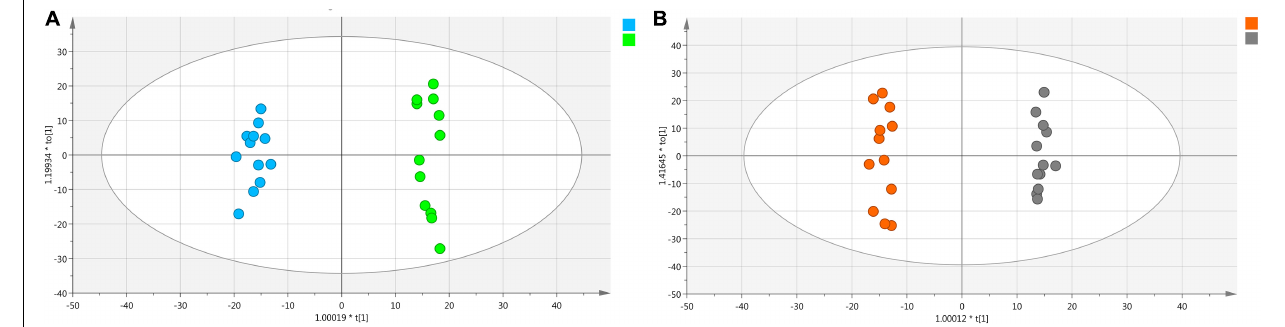
FIGURE 5 | OPLS-DA analysis of whole roots with and without “pockmarks” (A) and the divided roots with and without “pockmarks” of P. lactiflora (B) . The blue dot represents the whole root with “pockmarks,” green dot represents the whole root without “pockmarks,” orange dot represents divided root without “pockmarks,” and gray dot represents divided root with